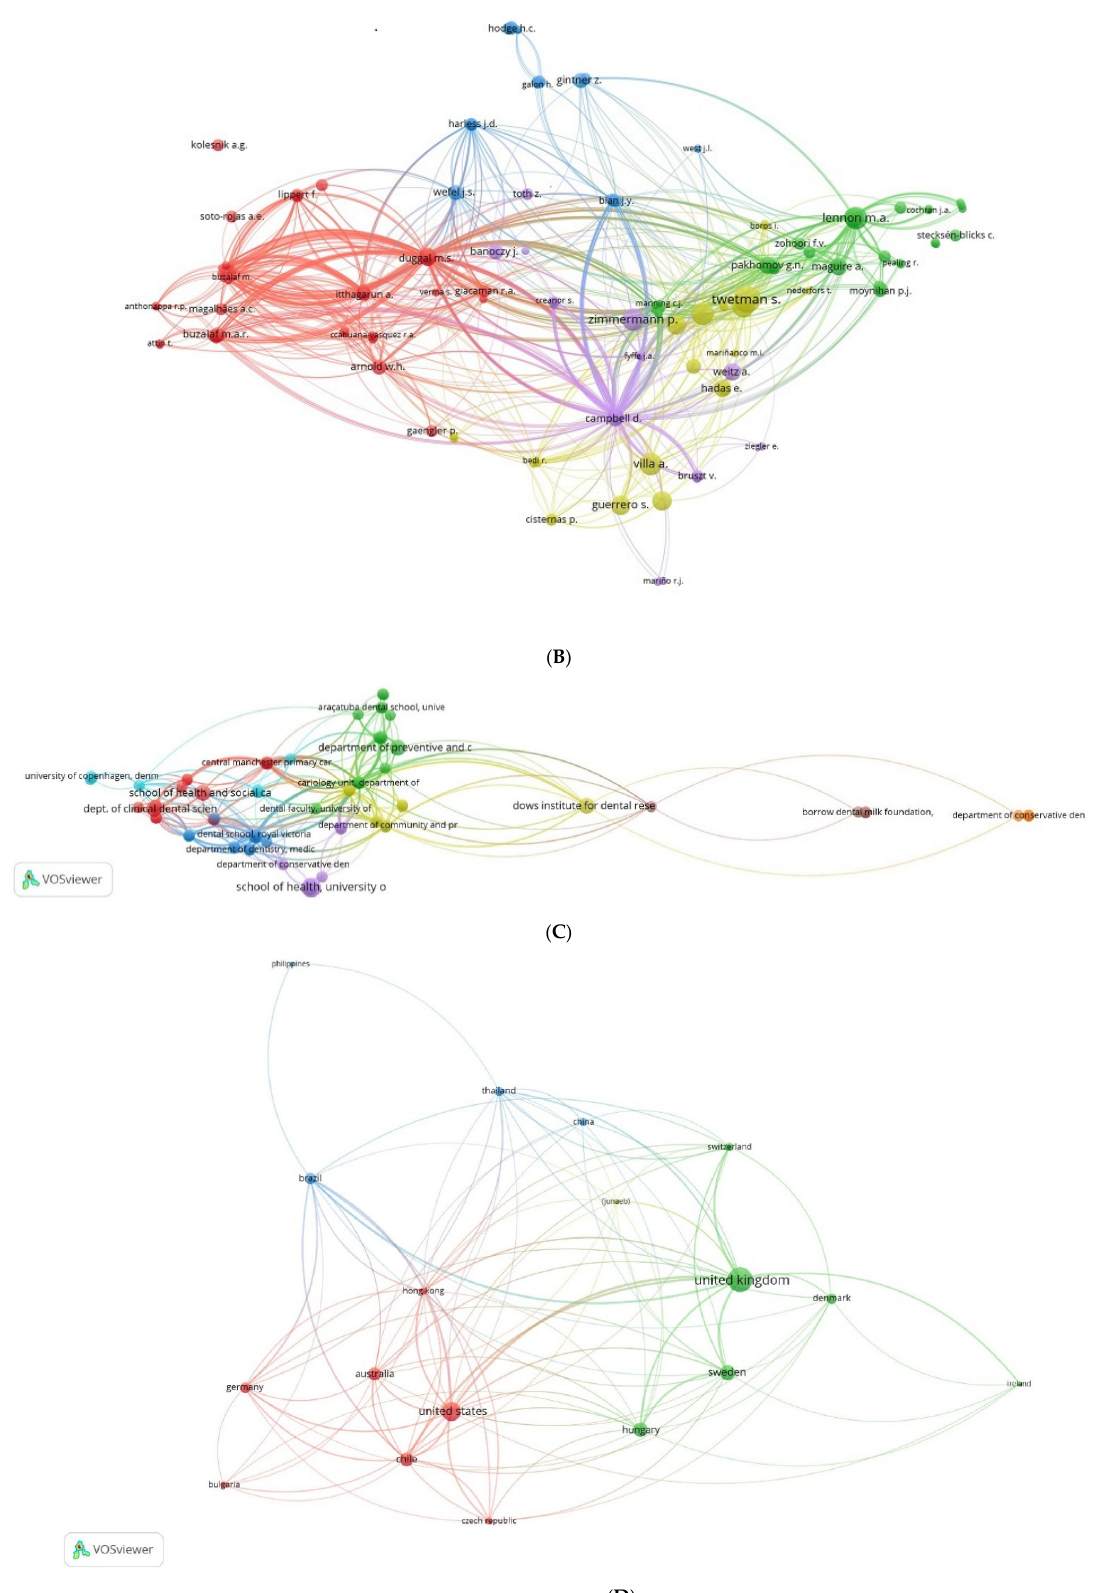
Figure 8. ( A ) Network visualization of citations among journals; ( B ) Network visualization of citations among authors; ( C ) Network visualization of citations among institutions; ( D ) Network visualization of citations among countries and territories.